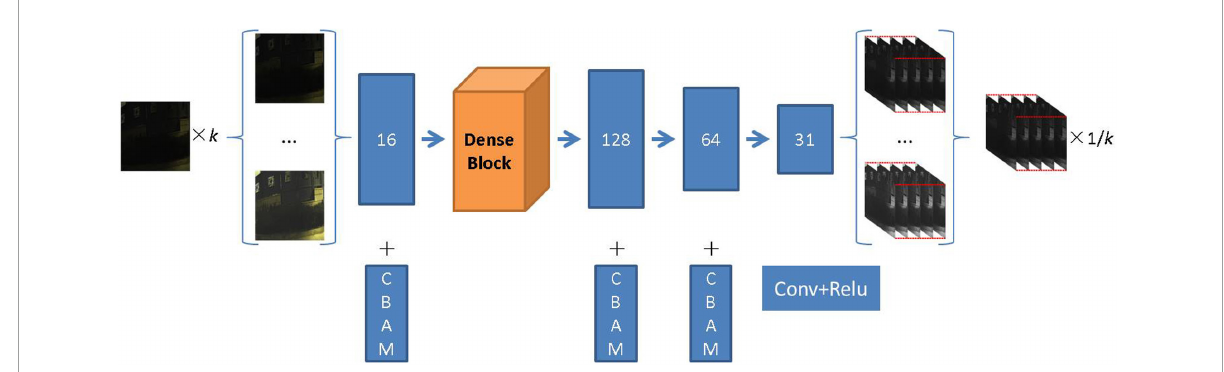
FIGURE2 Schematic diagram of training the deep learning-based spectral reconstruction model based on data augmentation. The photos appearing in these figures are chosen from the public multispectral dataset from the NTIRE challenges (https://icvl.cs.bgu.ac.il/projects/ntire2020/).